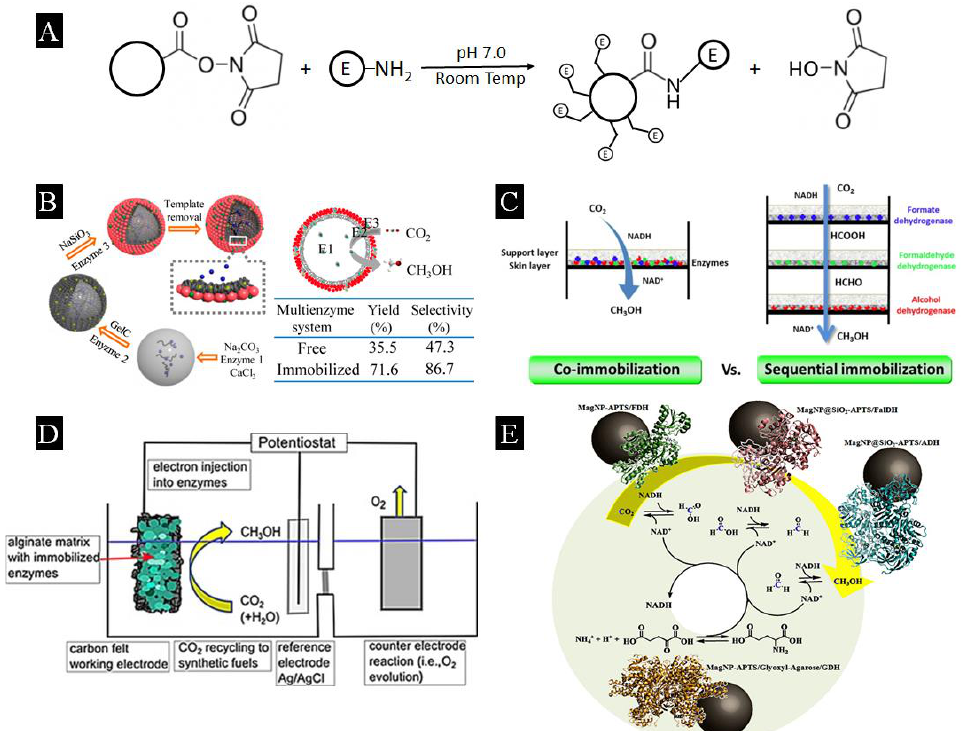
Figure 4. ( A ) Chemical route for the attachment of enzymes and cofactor onto polystyrene particles. Reproduced with permission from El-Zahab et al. [74] Copyright 2008 Wiley. ( B ) GelCSi microcapsules with enzymes. Reproduced with permission from Wang et al. [57] Copyright 2014 American Chemical Society. ( C ) Co-immobilization and sequential immobilization of enzymes in membranes for methanol production from CO 2 . Reproduced with permission from Luo et al. [17] Copyright 2015 Elsevier. ( D ) Electrochemical CO 2 reduction using enzymes. Reproduced with permission from Schlager et al. [75] Copyright 2016 Wiley. ( E ) CO 2 -methanol cycle using immobilized FDH, FaDH, and ADH. Originally published in Marques Netto et al. [77] under Creative Commons Attribution 4.0 International License.